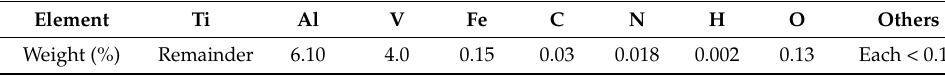
Table 1. Elemental composition of Ti6Al4V.